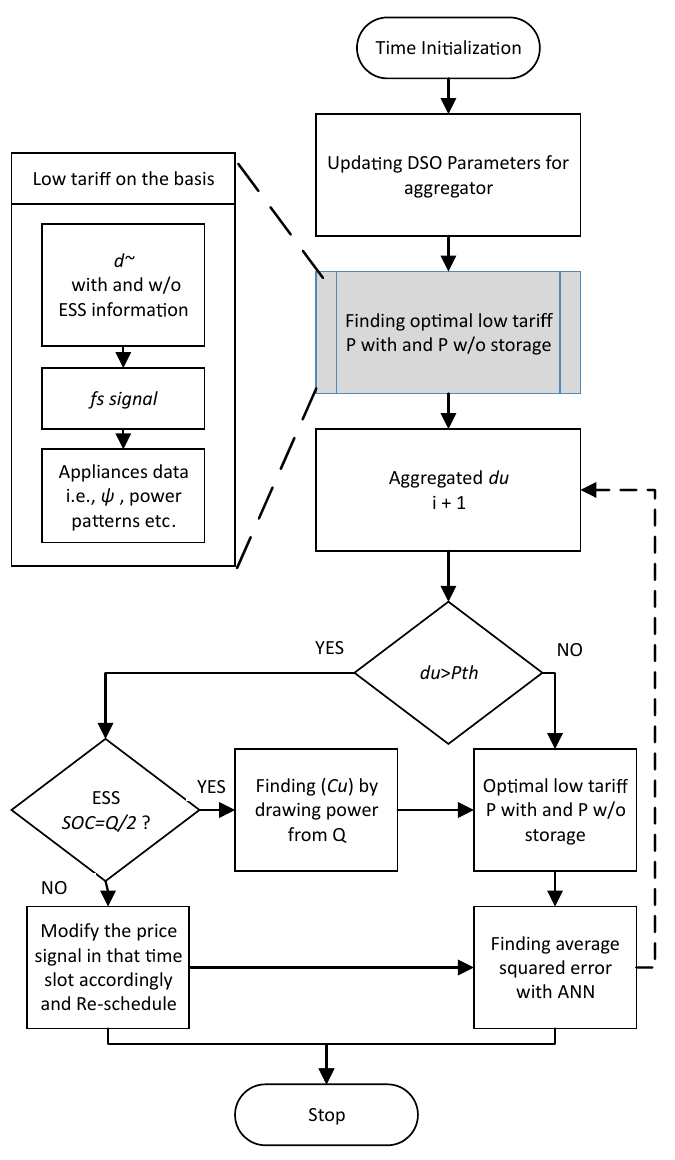
Figure 3. Flow-chart of the proposed